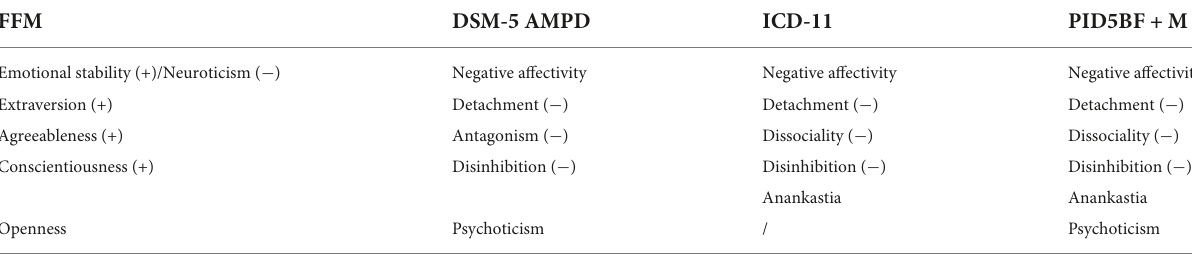
TABLE 1 FFM, DSM-5 AMPD, ICD-11 classification of personality disorders, and PID5BF + M (pathological) trait descriptors. FFM DSM-5 AMPD ICD-11 Emotional stability (+)/Neuroticism ( − ) Negative